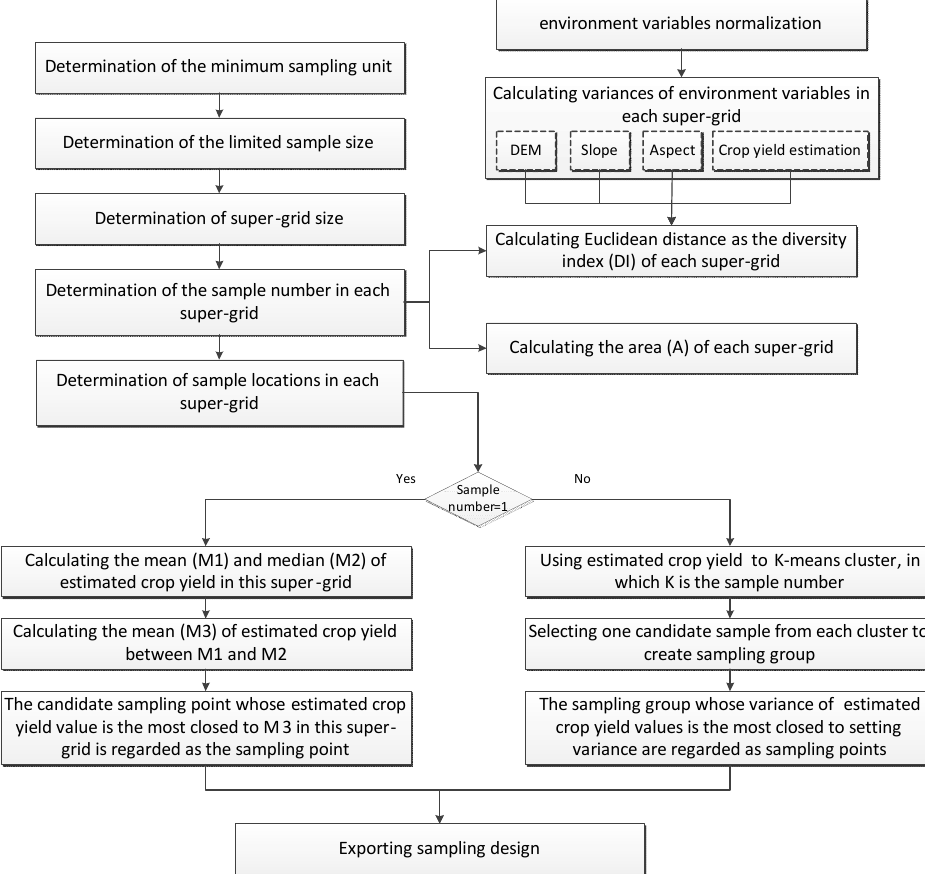
Figure 2. The schematic of the proposed sampling design method for farm field-level soil mapping.